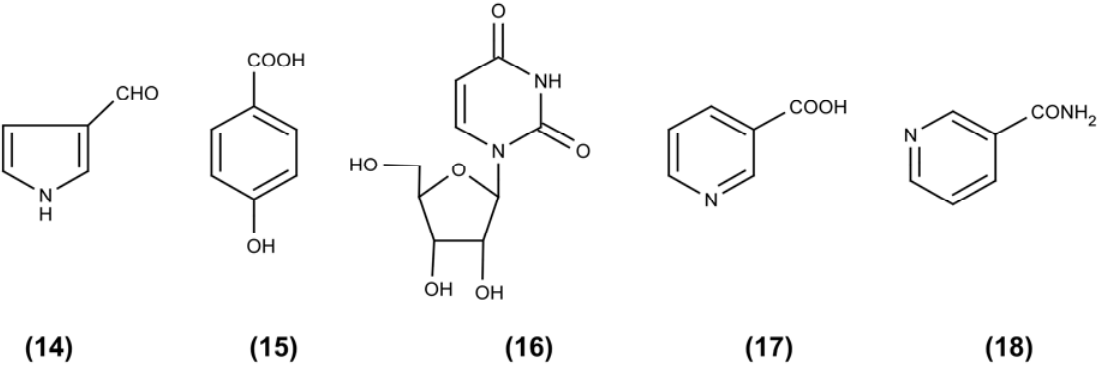
Figure 3. Structures of metabolites isolated from the phenolic fraction of the methanolic (MeOH) extract derived from P. ostreatus grown in submerged culture in a batch stirred tank